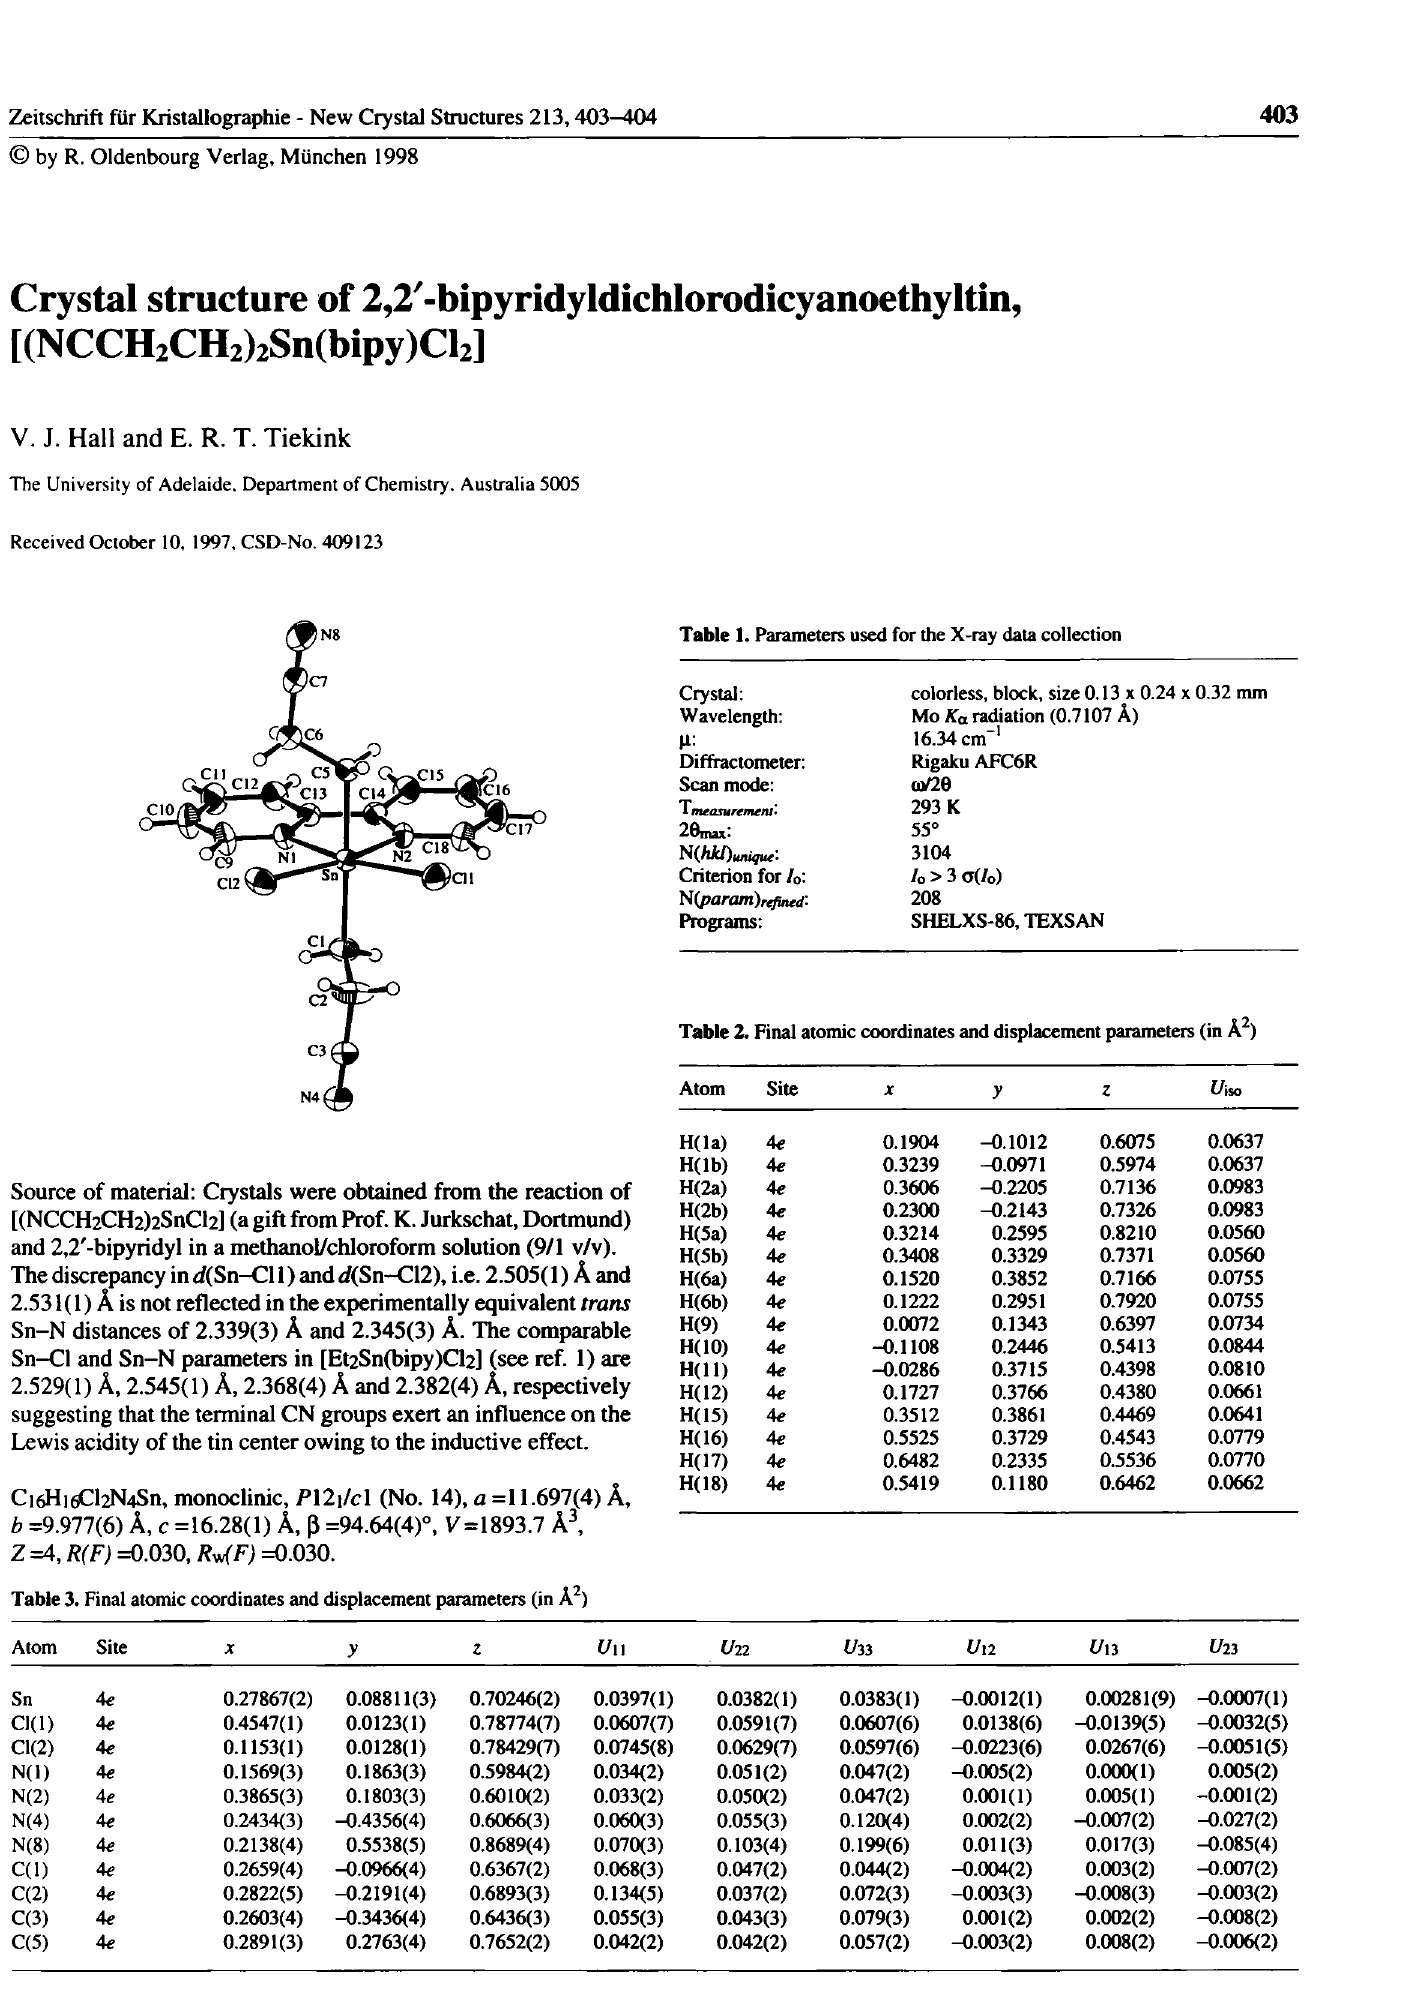
Table 3. Final atomic coordinates and displacement parameters (in Â^)